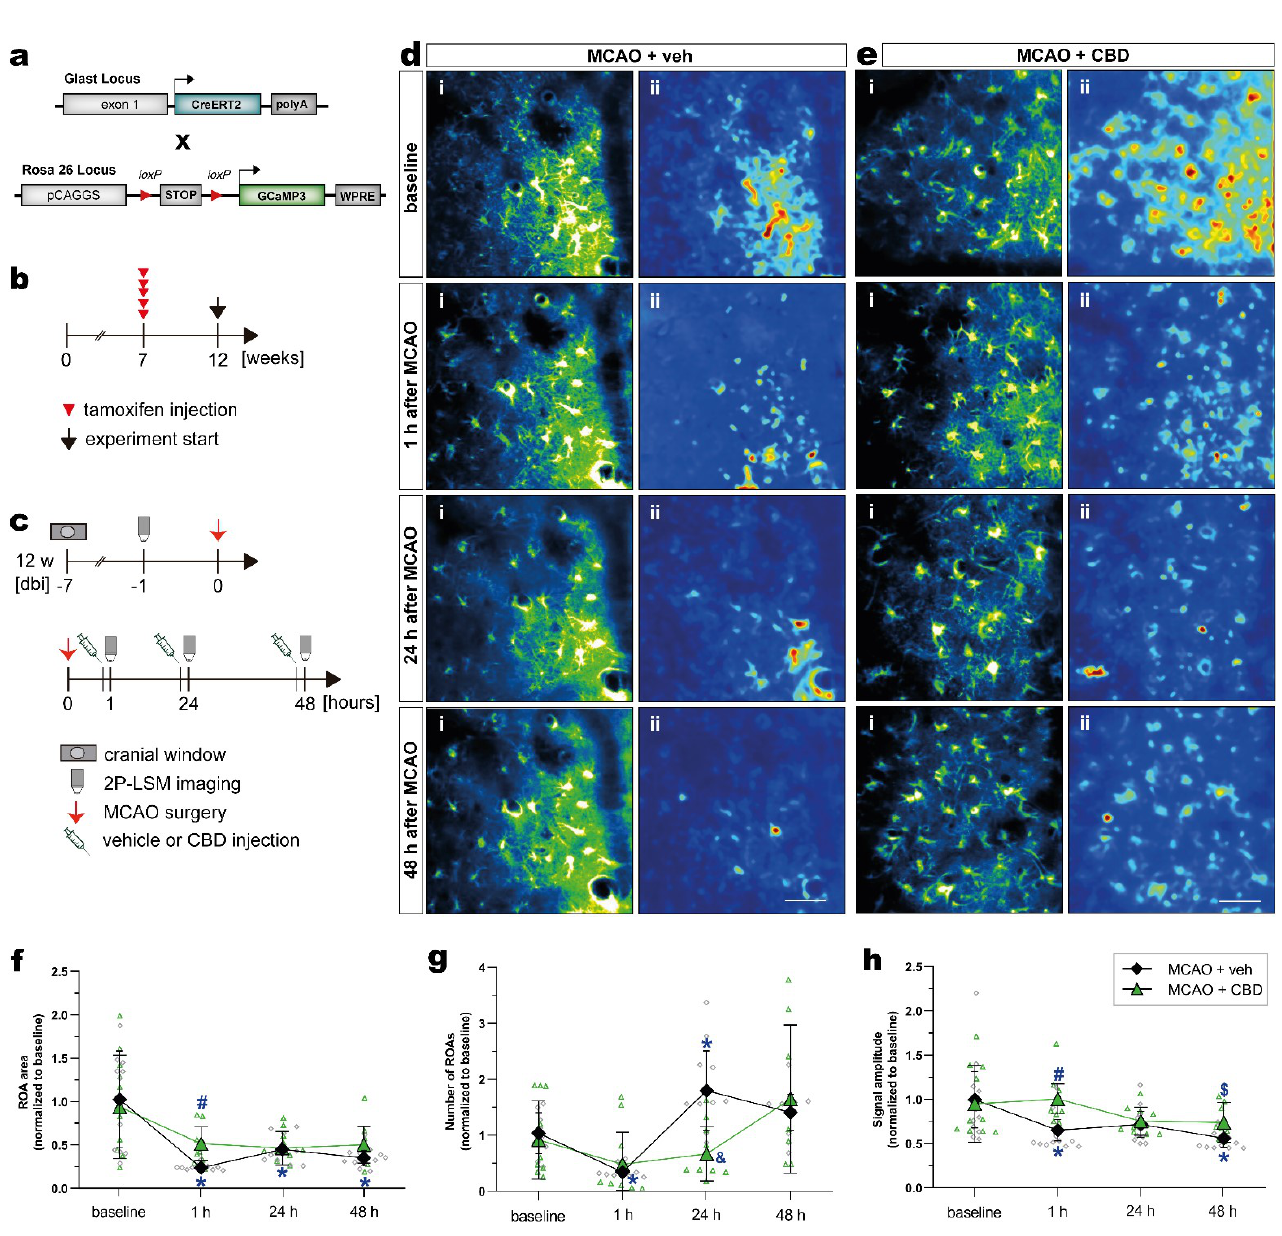
Figure 4. Activity-based in vivo astrocytic Ca 2+ signals showed higher signal amplitude and ROA area in the cortex of ischemic mice treated with CBD. ( a ) Scheme of transgenic constructs carrying CreERT2 and GCaMP3. ( b , c ) Experimental design: GCaMP3 induction was achieved in 7-week-old mice injected with tamoxifen (b). GLAST GCAMP3 mice underwent cortical craniotomy and, after 1 week recovery, were submitted to the MCAO. The ischemic mice were injected with vehicle or CBD, and in vivo 2P-LSM imaging was performed before MCAO (baseline) and 30 min after the injections (c). ( d , e ) Automated Ca 2+ signaling analysis for ischemic mice treated with vehicle (d) or CBD (e) using a custom-made MATLAB-based software toolbox. Maximum-intensity projections of GCaMP3 signals for representative FOV (i) over the entire recording time (up to 5 min) and relative fluorescence change projection (ii). ( f ) ROA area. ( g ) Number of ROAs. ( h ) Signal amplitude. Single datasets were analyzed using a Shapiro – Wilk normality test, and data were compared using a two- way repeated measures ANOVA with Sidak ’ s multiple comparisons test. Group was the between- subject factor and time (test day) was the within- subject factor. Student’s unpaired t -test was used to compare the time points between experimental groups. * p ≤ 0.05 compared to MCAO + veh group at baseline, # p ≤ 0.05 compared to MCAO + veh group at 1 h, & p ≤ 0.05 compared to MCAO + veh group at 24 h, and $ p ≤ 0.05 compared to MCAO + veh group at 48 h. Scale bars: 50 µm (d ,e). 2P-